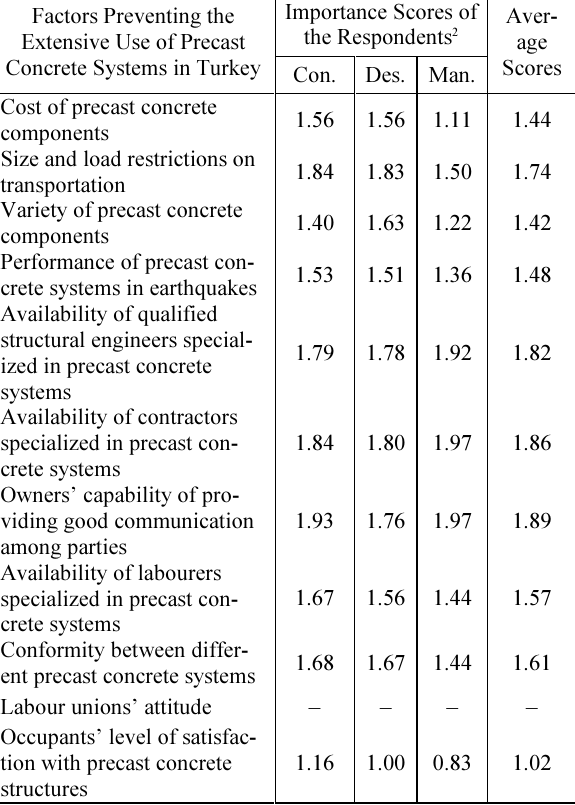
Table 3. Factors Preventing the Extensive Use of Precast Factors Preventing the the Respondents 2 Extensive Use of